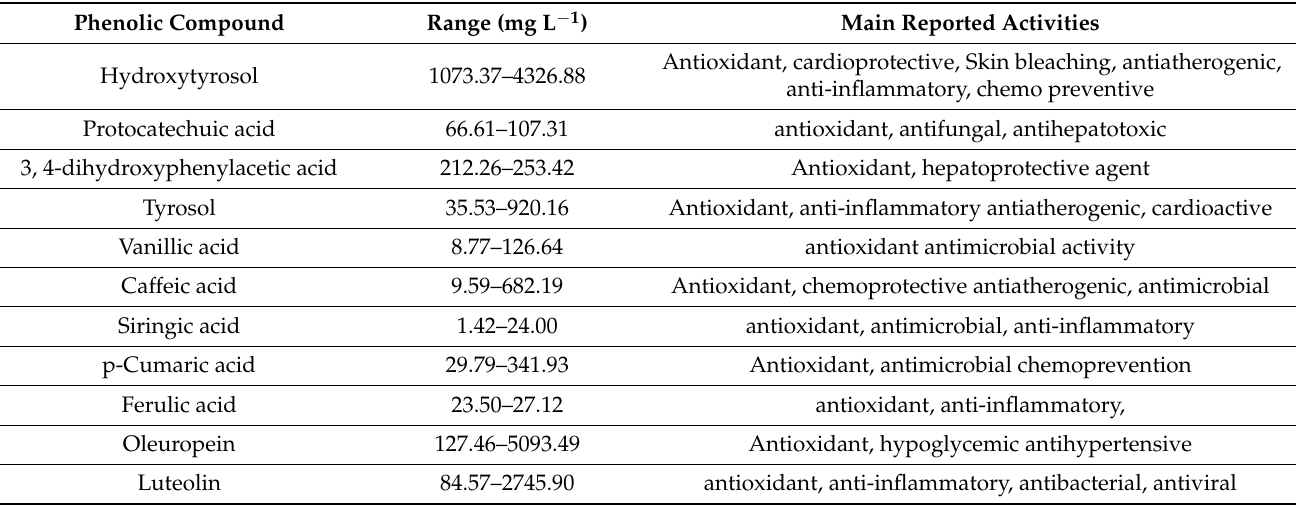
Table 8. The concentration of phenolic compounds present in OMW and their main reported activities. Adapted from References